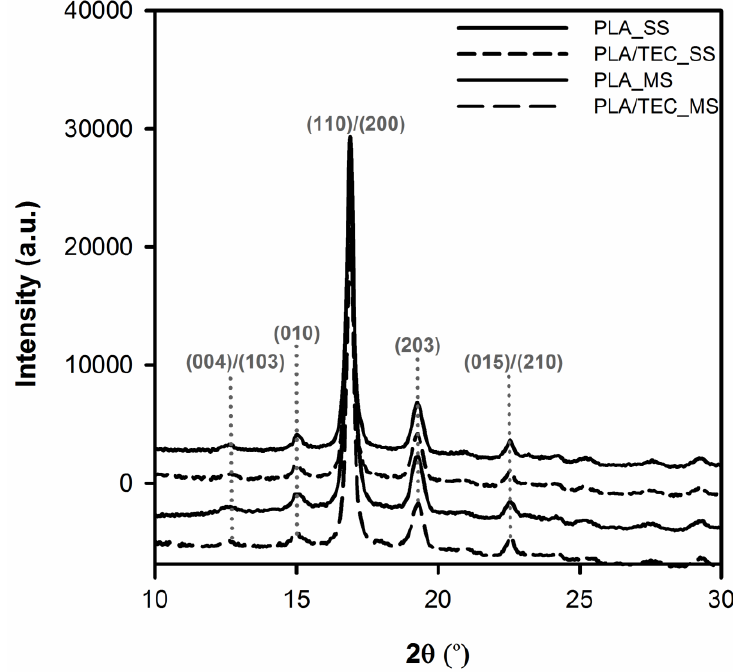
Figure 7. The difference spectra of PLA and PLA/TEC samples obtained from the FTIR spectra shown in Figure 6 by subtracting the amorphous PLA spectrum.